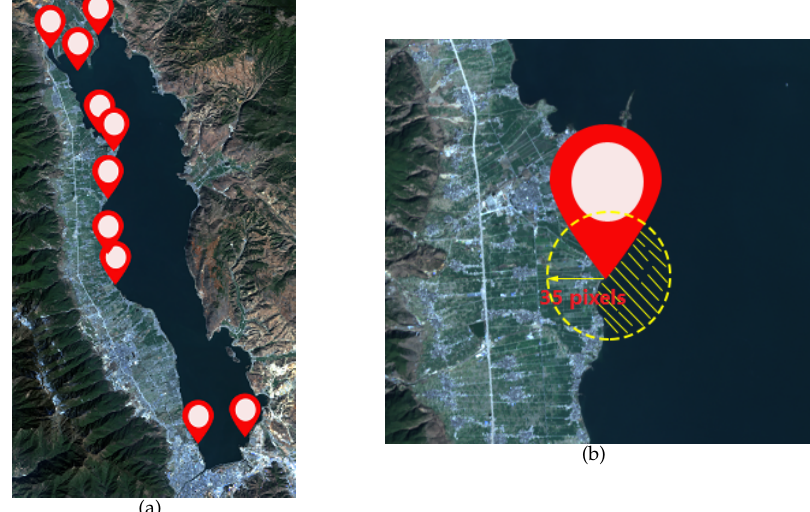
Figure 4. Monitoring stations’ location. ( a ) Ten monitoring stations’ location in Erhai Lake. ( b ) Coverage area of a